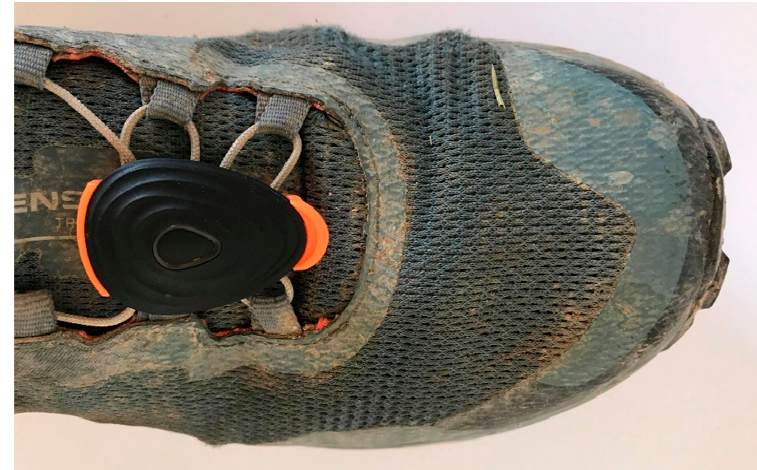
Figure 3. The Stryd sensor fixed on the right shoe of one of the participants.